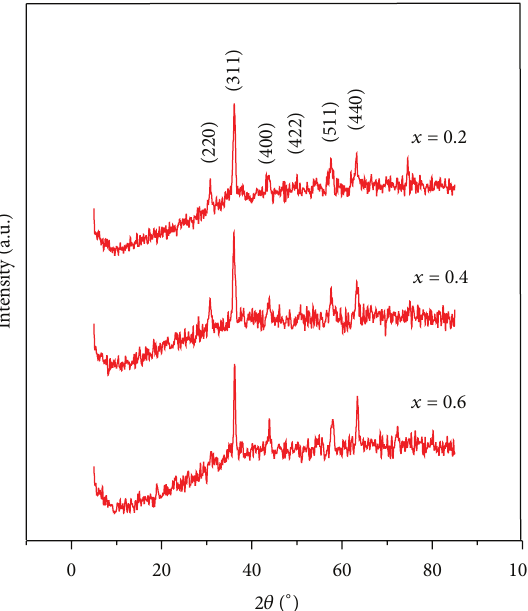
Figure 1: XRD patterns of nickel cobalt zinc ferrite.